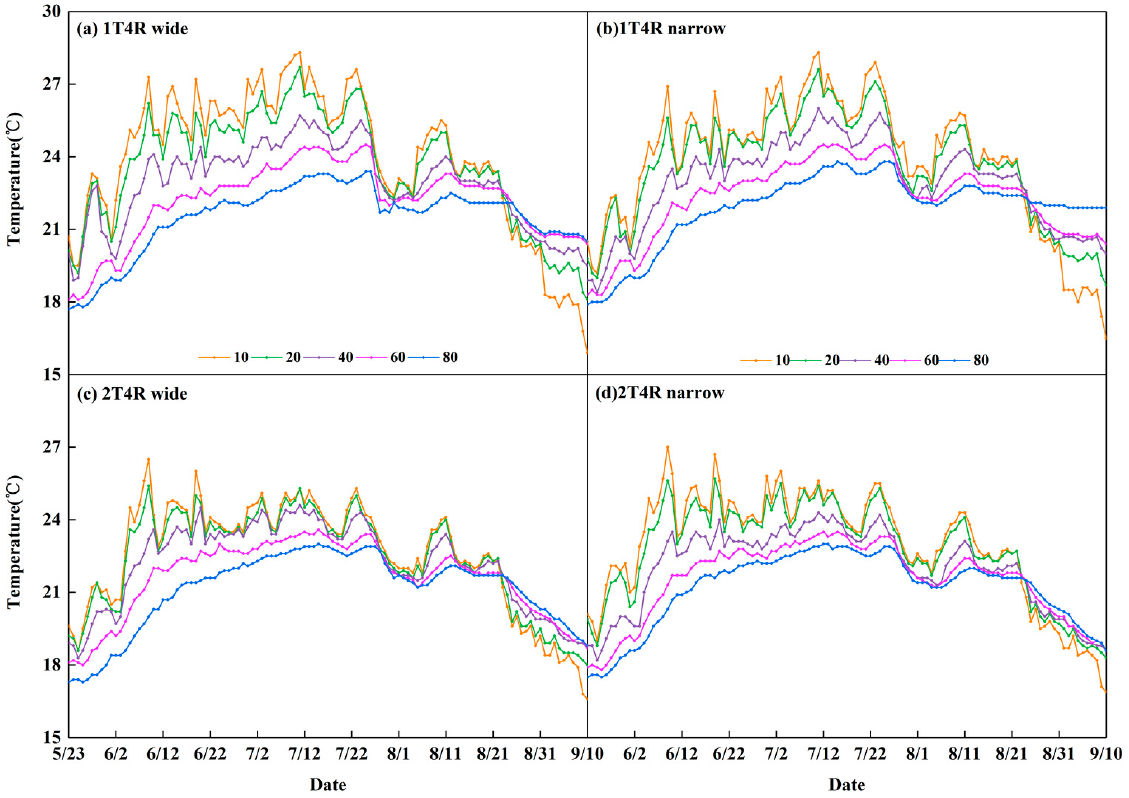
Figure 7. Dynamic changes of soil temperature in different drip irrigation treatment conditions in 2018a. ( a ) 1T4R wide, ( b ) 1T4R narrow, ( c ) 2T4R wide, ( d ) 2T4R narrow.